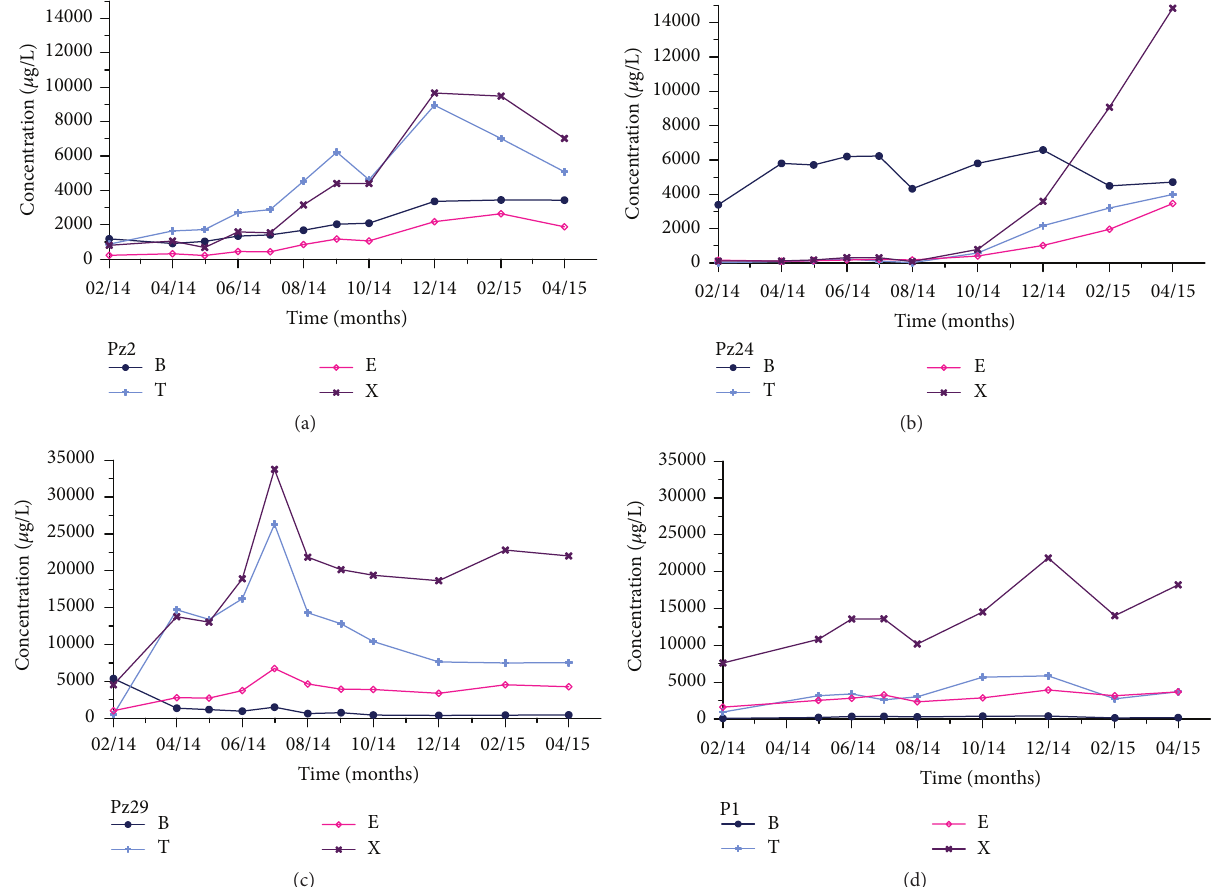
Figure 6: Evolution of BTEX (benzene, toluene, ethylbenzene, and xylenes) concentrations in water over time, measured in four monitoring piezometers: Pz2 (a), Pz24 (b), Pz29 (c), and P1 (d), between February 2014 and April